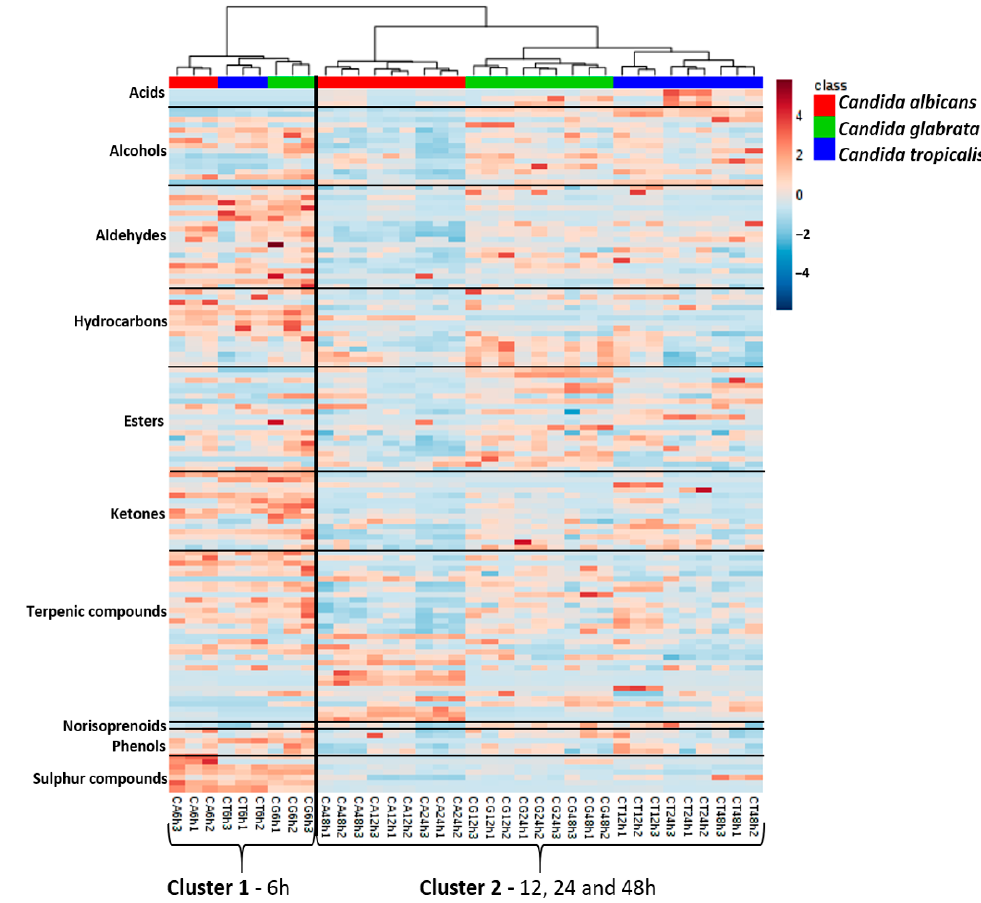
Figure 6. Heatmap and hierarchical cluster analysis representation of 126 metabolites putatively identified from Candida species cultures. The heatmap comprises the data obtained from the cultures of C. albicans , C. glabrata and C. tropicalis at 37 °C and 6, 12, 24 and 48 h of growth time. Cluster 1—samples from 6 h of growth, and Cluster 2—samples from 12, 24 and 48 h of growth. The area of each variable was autoscaled and normalized by the sum for all samples (with a GC peak previously normalized by CFU mL − 1 ). n = 3 for each condition under study. The content of each metabolite was illustrated through a chromatic scale (from blue, minimum, to red, maximum). Hierarchical